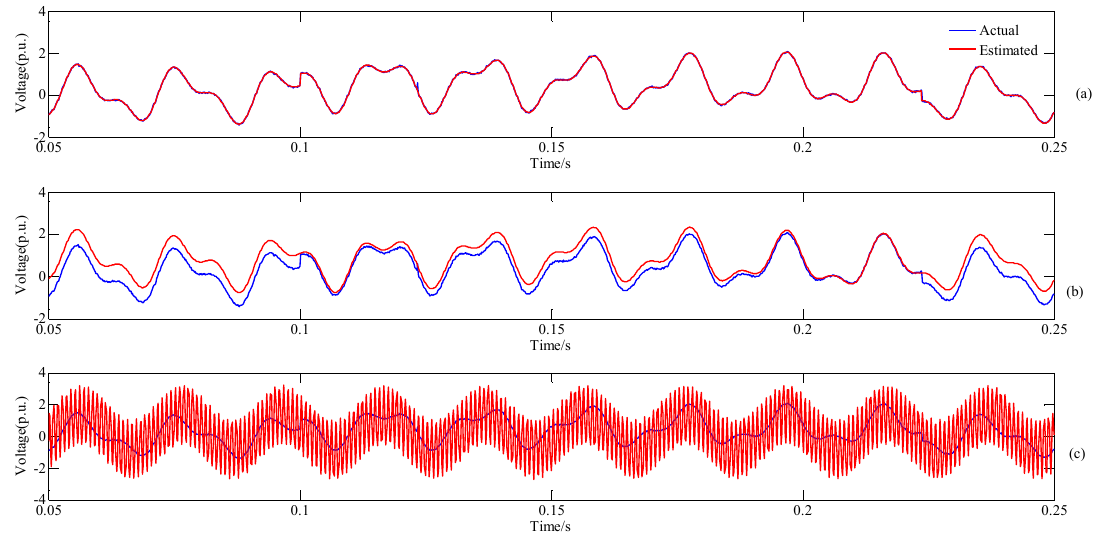
Figure 11. Source signal and the reconstruction of Equation (21) by using ( a ) The proposed method; ( b ) TLS-ESPRIT; ( c ) Prony method.